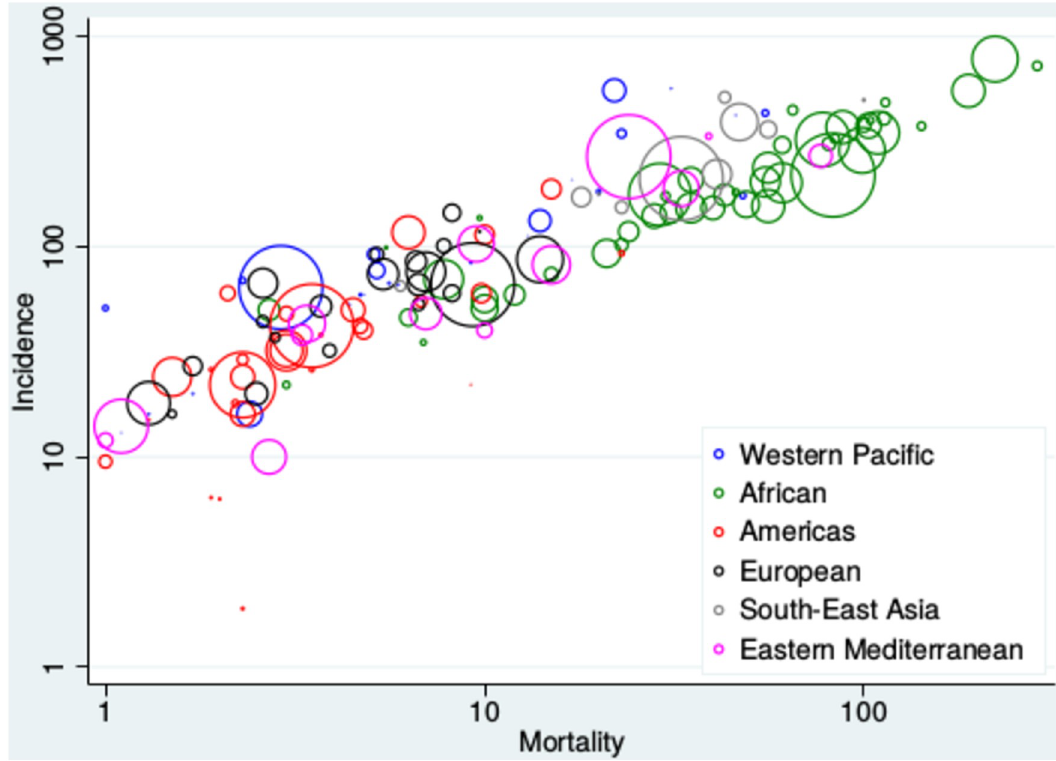
Fig 10. Illustration of global TB burden by country with colouring by region using global TB report data [6]. Note again that the diameter of the circle is proportional to the population of the country.